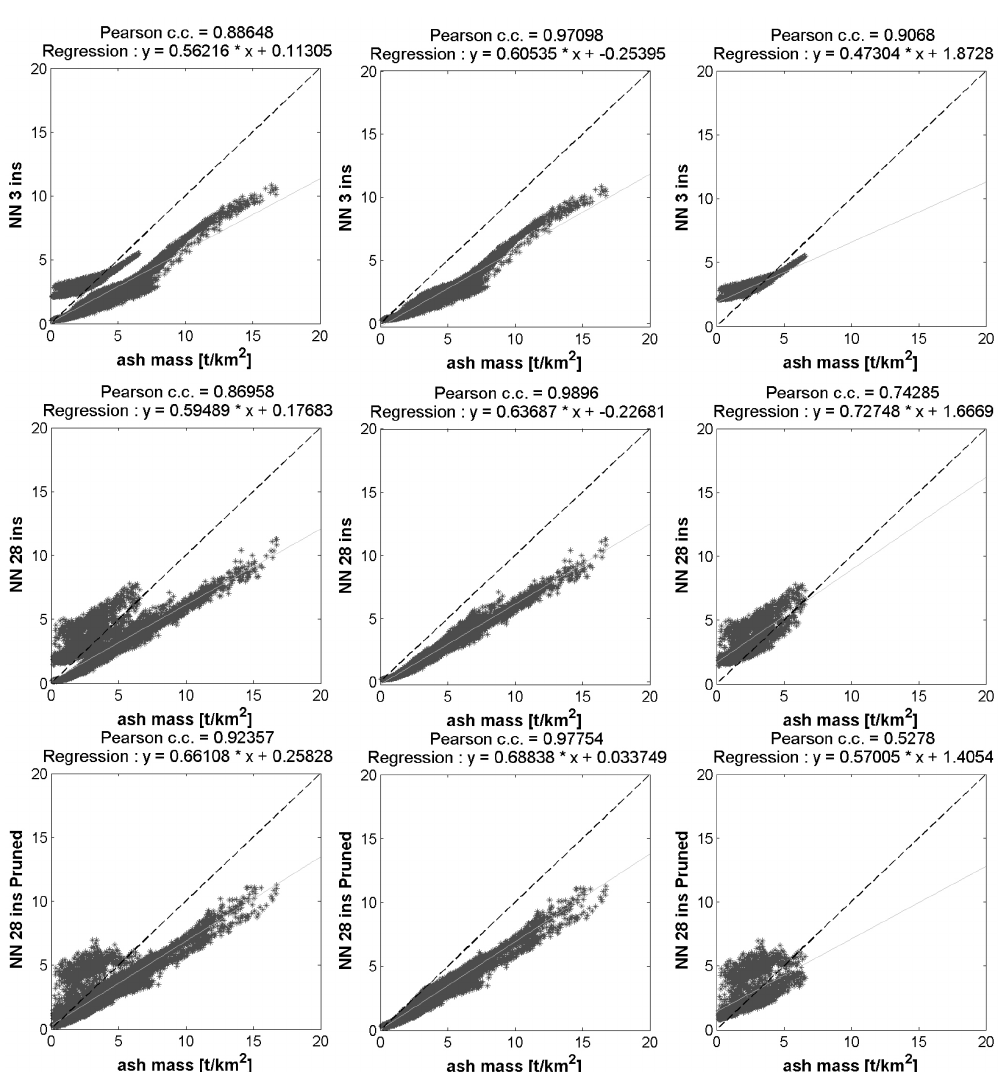
Figure 5. Scatterplots for ash mass networks, 3 inputs (top row), 28 inputs (middle row) and 28 inputs pruned (bottom row), applied to the validation set of 11 May 2010, 14:05UTC, divided into total patterns (left column), patterns over sea (middle column) and patterns over meteorological clouds (right column).